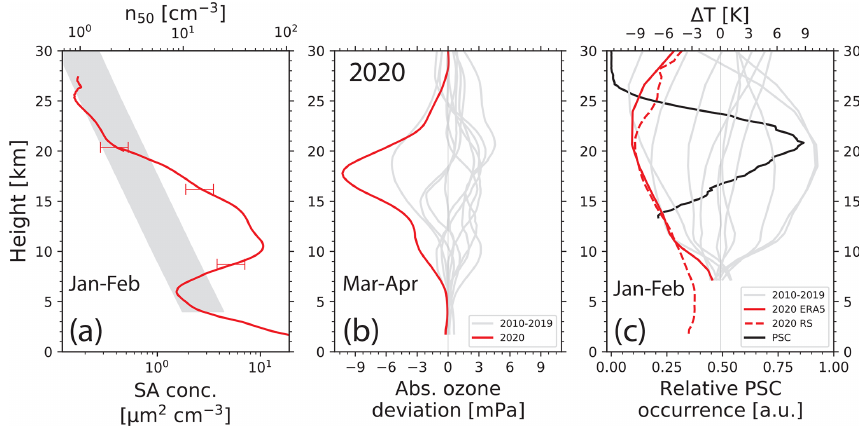
Figure 12. (a) Winter (January–February) mean profiles of the particle surface area (SA) concentration and number concentration n 50 (particles with radius > 50nm) estimated from lidar observations aboard Polarstern in 2020. Horizontal red bars indicate a SA retrieval uncertainty of 35%. Background aerosol conditions are given as a gray shaded area (based on lidar observations at Tsukuba, Japan) (Sakai et al., 2016). (b) Additional ozone loss (red profile) for March–April 2020, i.e., absolute ozone deviations from the respective long-term March–April (2010–2019) mean ozone profile (see Eq. 2). Respective ozone deviations for the individual years from 2010–2019 are given as light gray profiles. (c) PSC height range (restricted to heights > 13km) and relative vertical distribution of the PSC frequency of occurrence (in arbitrary units) from CALIOP observations and mean temperature deviations (2020 ERA5 mean values for the 70–90 ◦ N latitudinal belt as a solid red profile, ozonesonde/radiosonde (2020 RS) data as a dashed red profile) for the main PSC months January–February 2020 from the respective January–February long-term mean profile (calculated with Eq. 5). Ozone- and radiosonde data collected at Ny-Ålesund are used in the ozone and temperature calculations (2020 RS